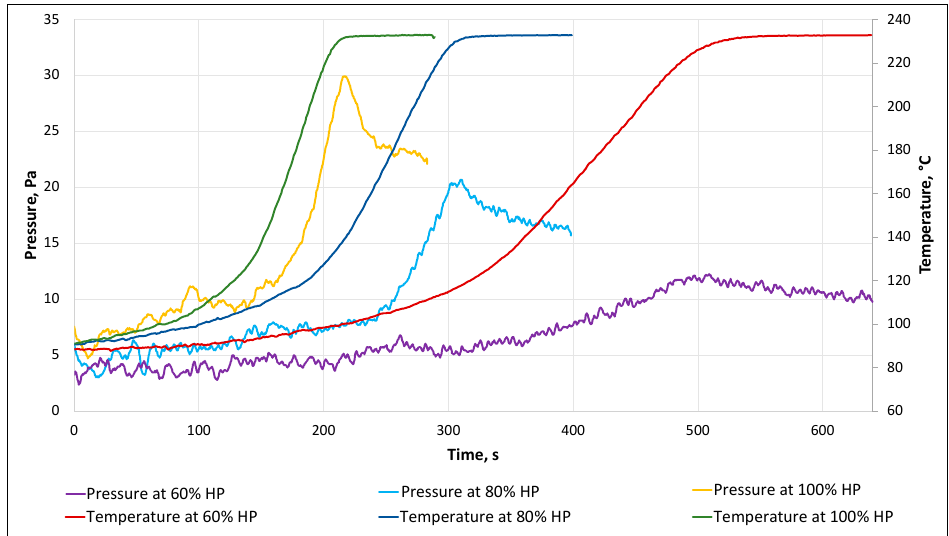
Figure 7. Pressure and temperature measurement with the variation of the heating power (*HP = heating